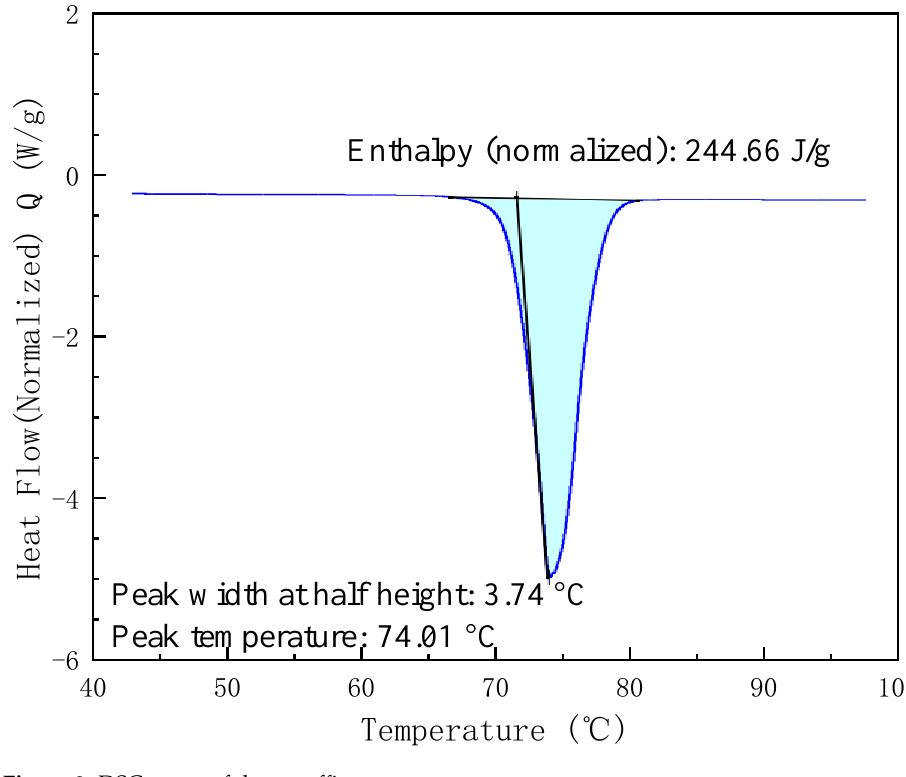
Figure 3. Weight of module ( a ) before PCM filling and ( b ) after PCM filling. The heat source was arranged at the bottom of the module. Three types of the heat sources with different geometries (30 mm × 30 mm, 40 mm × 40 mm, 50 mm × 50 mm) were designed and given 10 W, 20 W, and 30 W. The temperature rise of the heat source within 10 min was used as an indicator to analyze the heat dissipation capacity of each heat dissipation module under different heat source areas and different power densities.